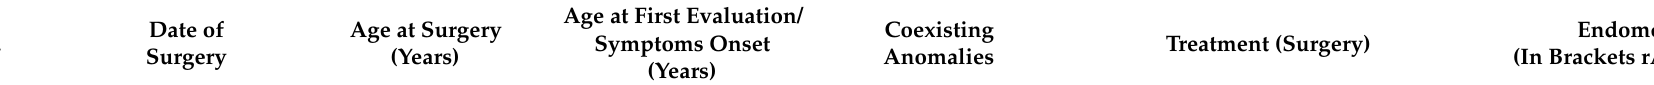
Table 1. Characteristics of 15 patients diagnosed with congenital obstructive anomalies of the genital tract associated with cryptomenorrhea (menstruation without external bleeding). The anomalies are categorized according to the European Society of Human Reproduction and Embryology and the European Society for Gynecological Endoscopy (ESHRE/ESGE) classification system of female genital tract congenital anomalies [10], and the American Society for Reproductive Medicine Müllerian anomalies classification (ASRM MAC) 2021 [11]. Endometriosis is staged according to the revised ASRM (rASRM) classification of endometriosis